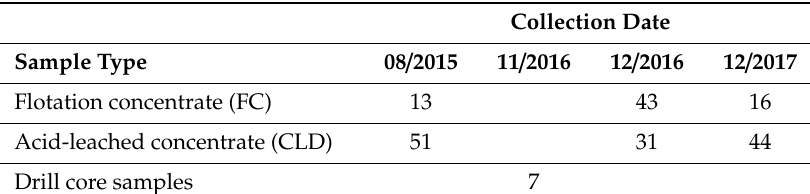
Table 1. The particles (sample grains) analyzed by nanoSIMS, per concentrate type and collection date. Between 7 and 26 isotope maps were collected for each, averaging ~14. A selected subset of these analyses is presented in this